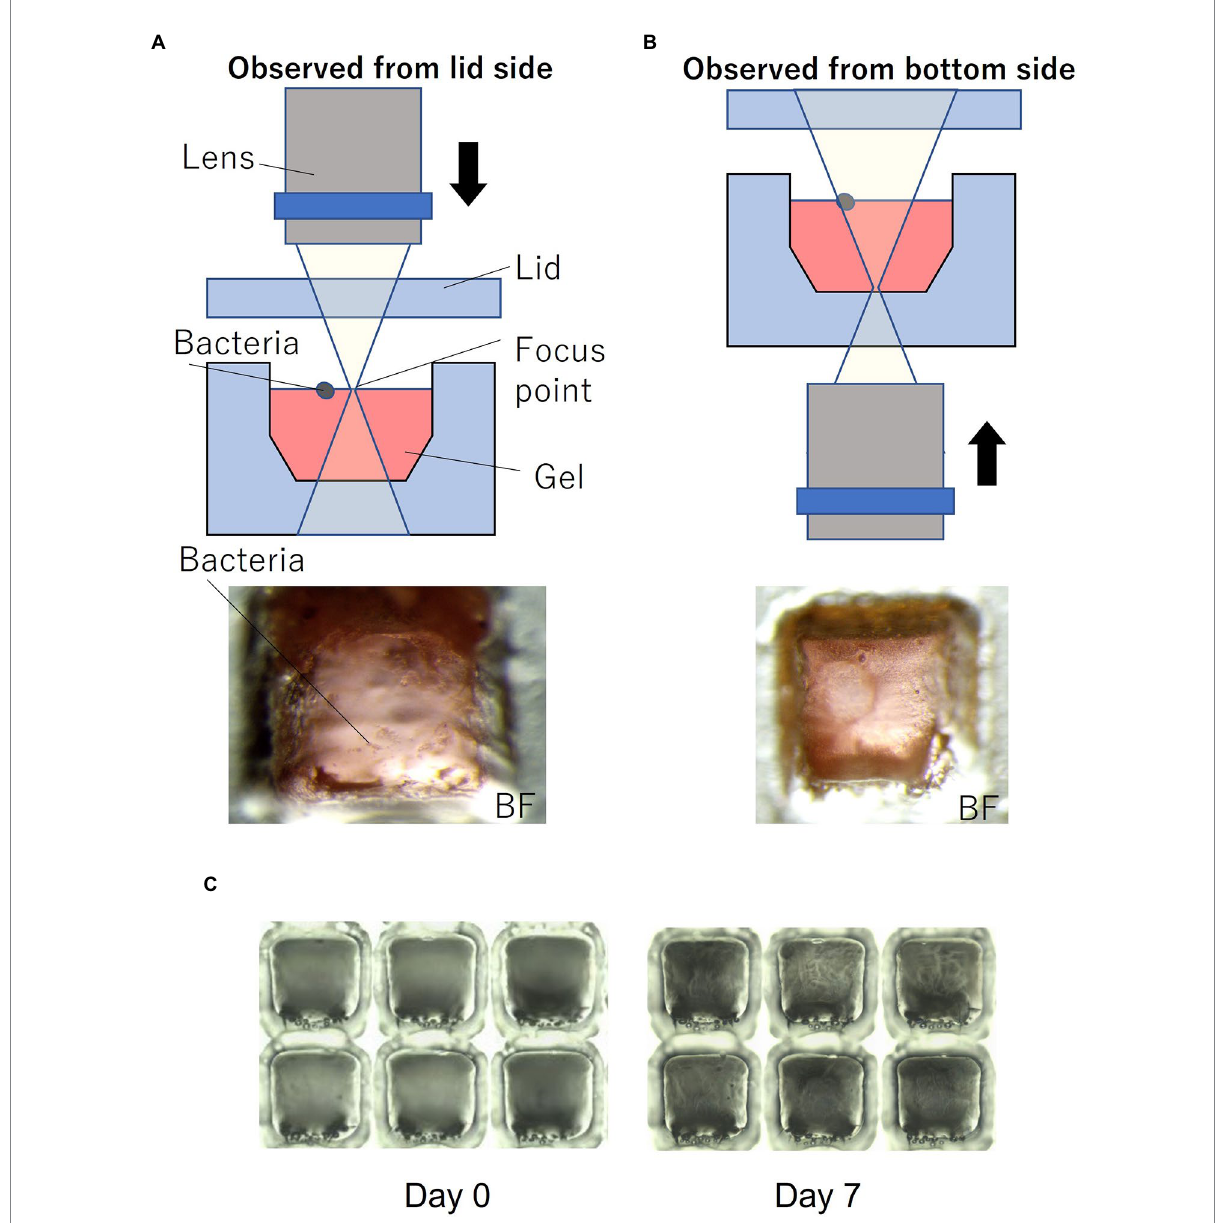
FIGURE 3 Microorganisms on the gel-filled microwell array. (A) Observation set up and micrograph from lid side. (B) Observation set up and micrograph from bottom side. (C) Micrograph of changes in the gel-filled device after 7 days at 30 °